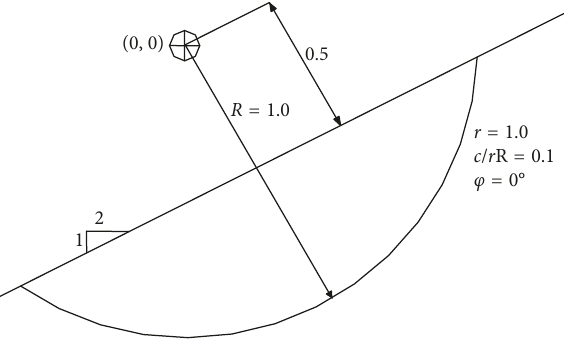
Figure 6: A spherical slip surface and parameters of a slope.